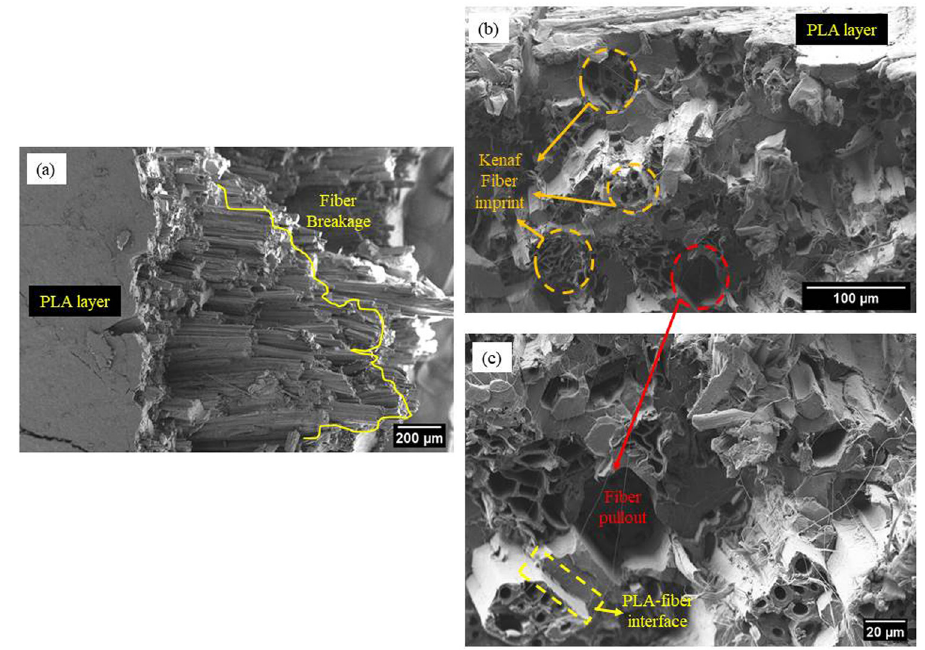
Figure 10: SEM micrographs of the tensile fractures of PLA – kenaf composites with a fi ber orientation of 0°: ( a ) Top view, ( b ) cross - sectional view, and ( c ) detailed